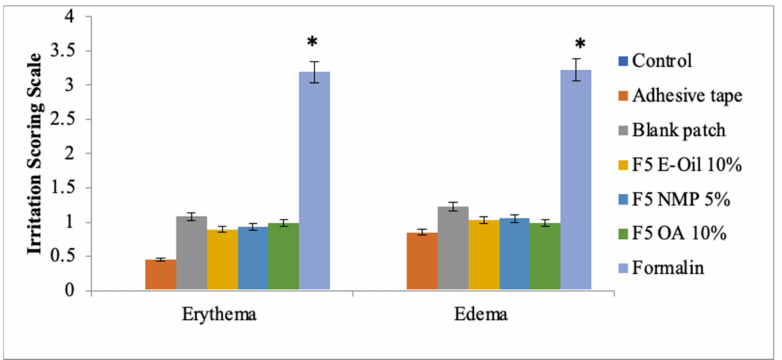
Figure 7. Skin irritation studies: erythema and edema. Data are expressed as mean ± SD; n = 3. One-way ANOVA followed by post hoc Tukey test; p < 0.05. (* p <0.05).